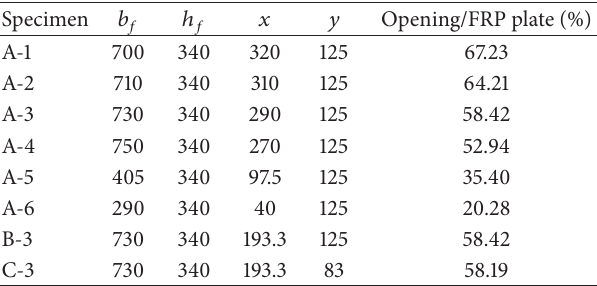
Table 3: Size and opening dimensions of FRP